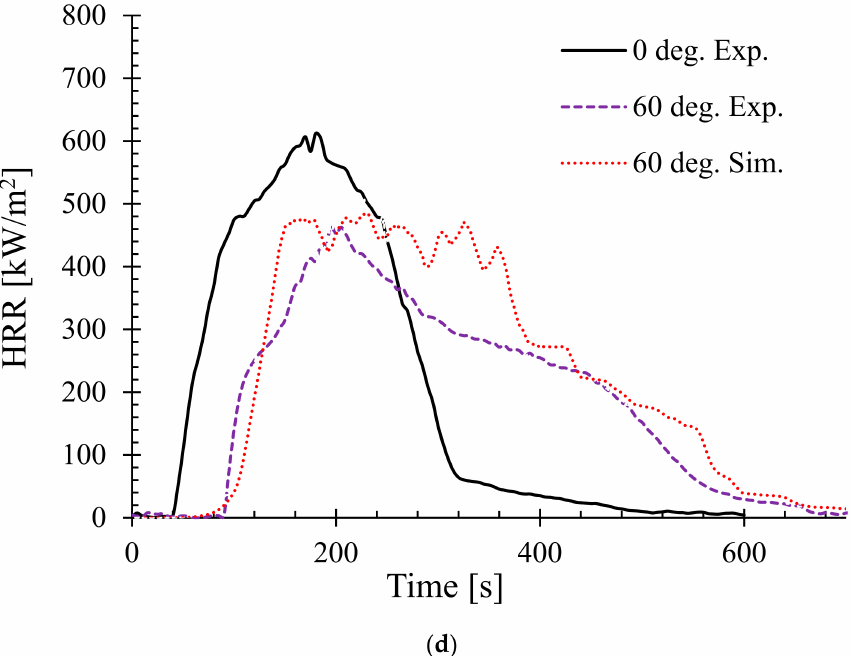
Figure 6. Heat release rates (HRR) for samples oriented at different angles at 35 kW/m 2 —( a ) 15 ◦ , ( b ) 30 ◦ , ( c ) 45 ◦ , and ( d ) 60 ◦